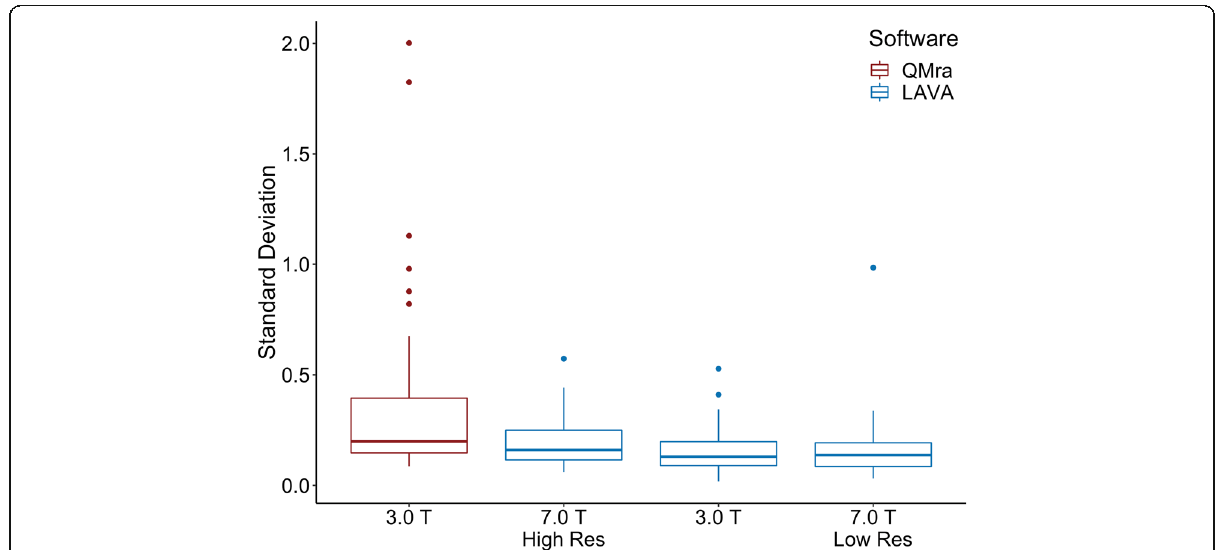
Fig. 1 Standard deviations of the intradural MMA measurements in the four analysis iterations. 7.0 T High Res: 7.0 T scan at full resolution; 7.0 T Low Res: 7.0 T scan resampled to 3.0 T